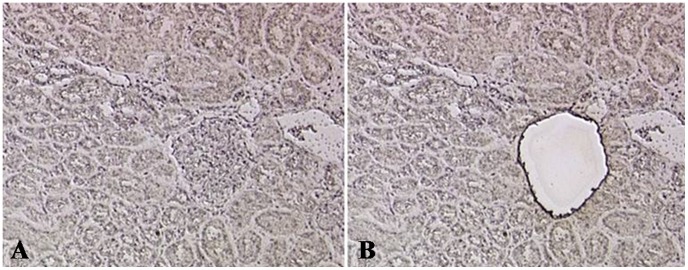
Histological picture of a laser microdissected biopsy.Example of laser-microdissection pre- (A) and post- (B) cut, showing that the glomerular tuft can be separated without any tubulo-interstitial contamination (Ematoxilin staining).